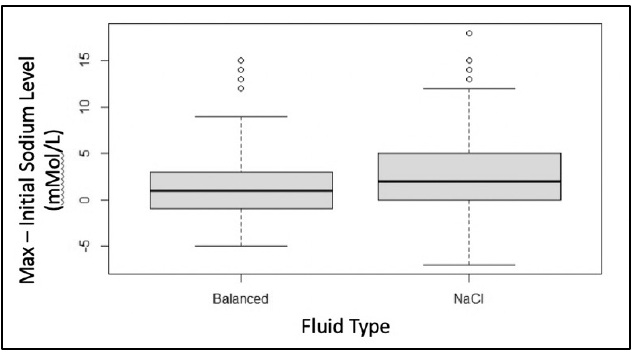
Figure 2. Comparison of the change in serum sodium level by subtracting initial sodium level from the maximum sodium level in the first 72 h of admission. The 0.9% saline group had a significantly higher increase in sodium level compared to the balanced solution group, p < 0.005.